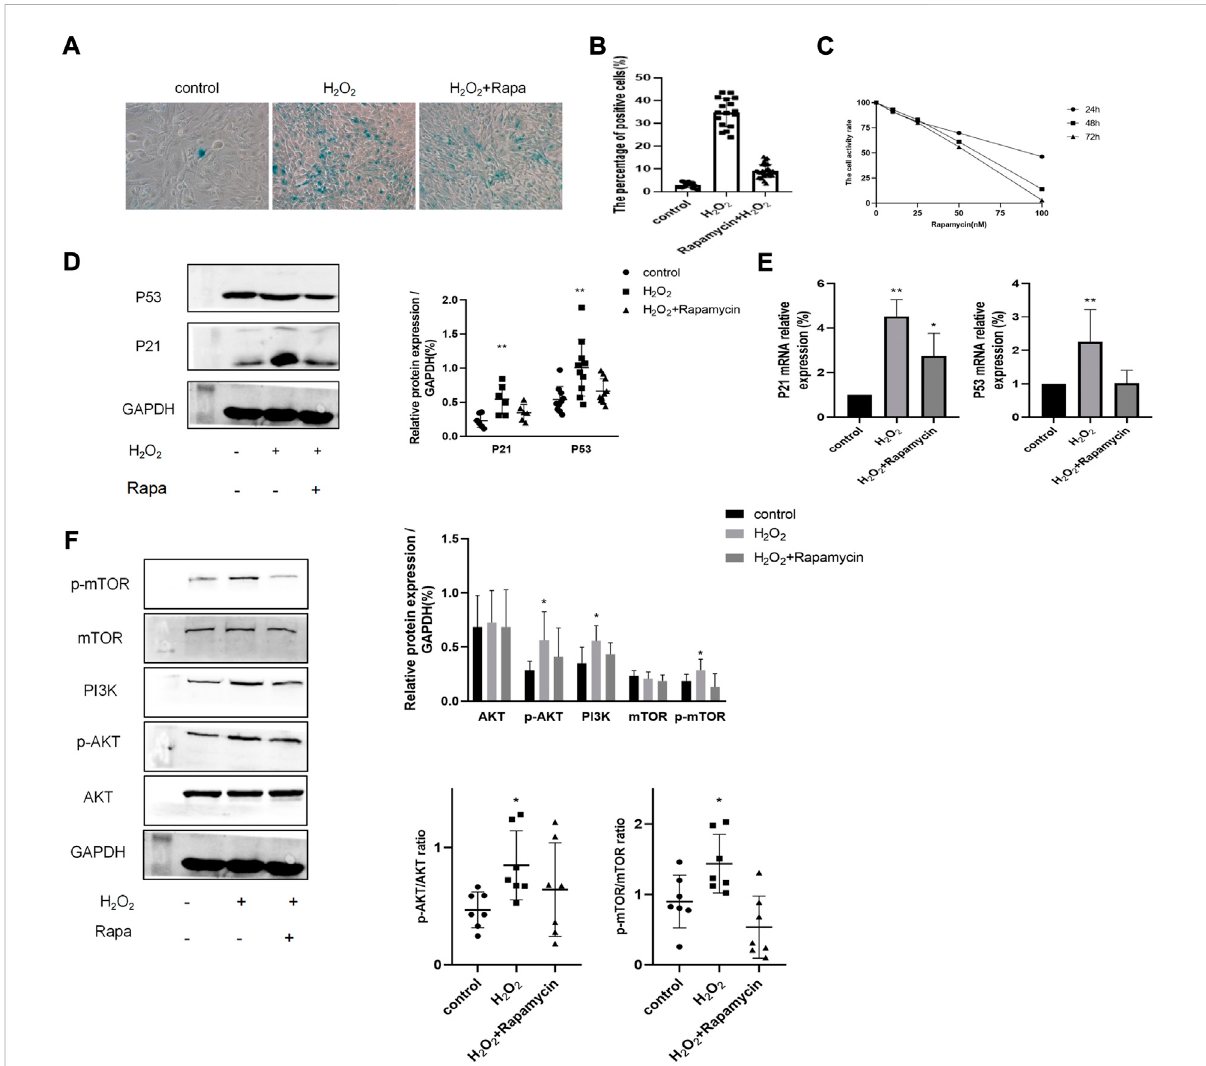
FIGURE 6 The PI3K-mTOR signaling pathway contributed to H 2 0 2 -induced cellular senescence in BEAS-2B cells. (A – B) SA-13-gal staining of BEAS-2B cells treated with orwithoutrapamycin and H202. Magni fi cation: ×200. (C) Cell viability assay ofBEAS-2B cells treated with differentconcentrations ofrapamycin. (D – E) ProteinandmRNAlevelsofP53andP21. (F) TheexpressionlevelofproteinsofthePI3K-mTORpathway.** p < 0.001,* p <